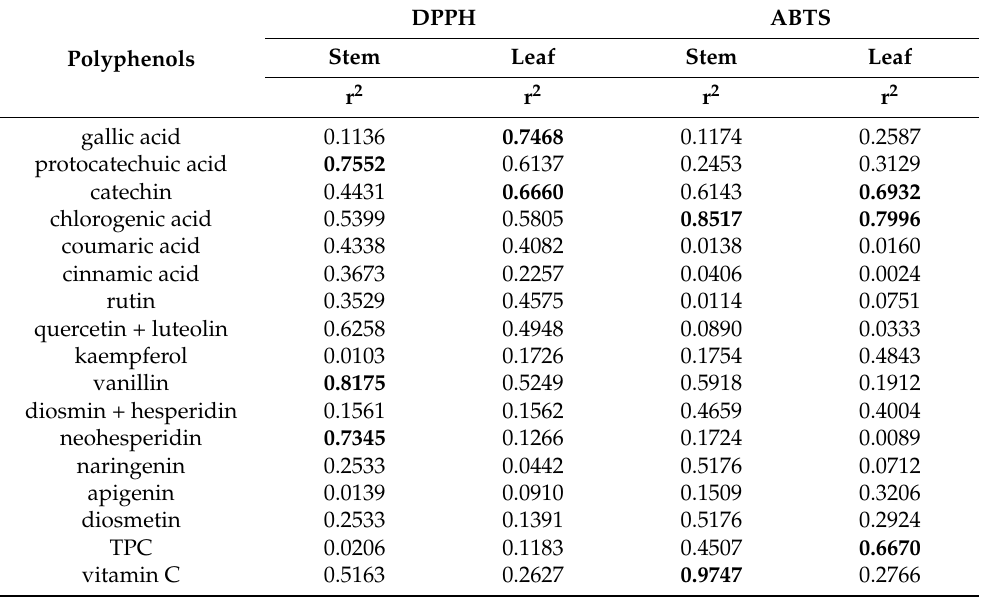
Table 4. Metabolites’ correlation with antioxidant capacity analyzed by DPPH and ABTS methodol- ogy in stems and leaves of habanero pepper ( Capsicum chinense